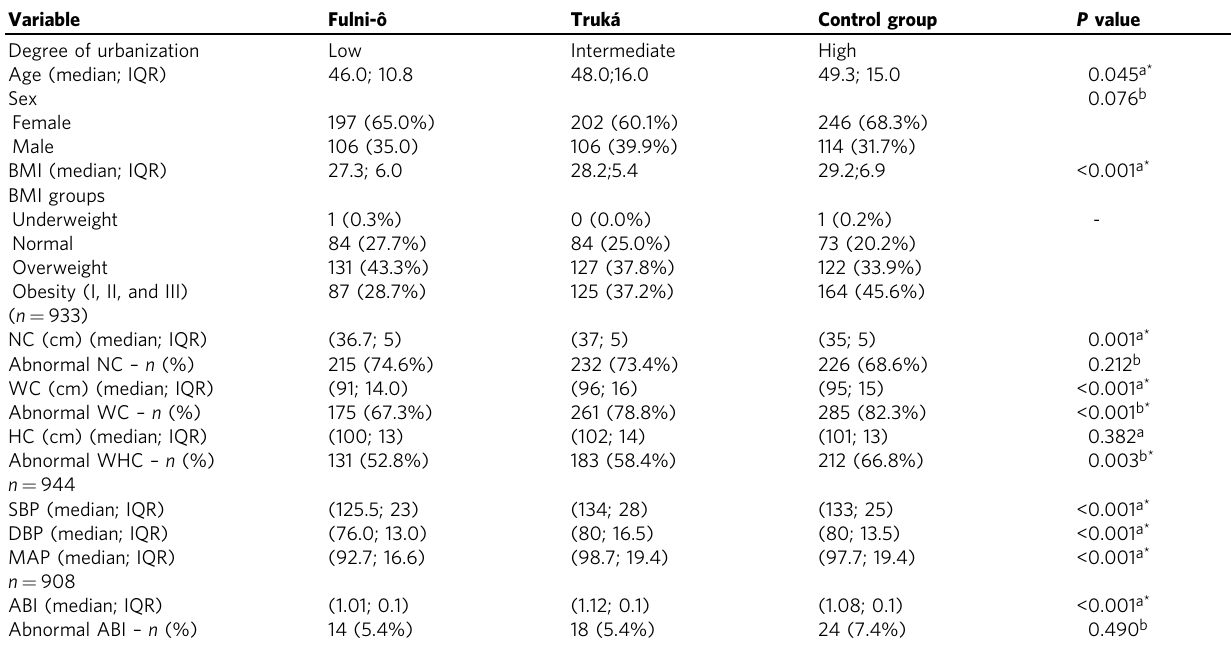
Table 1 Characterization of the studied